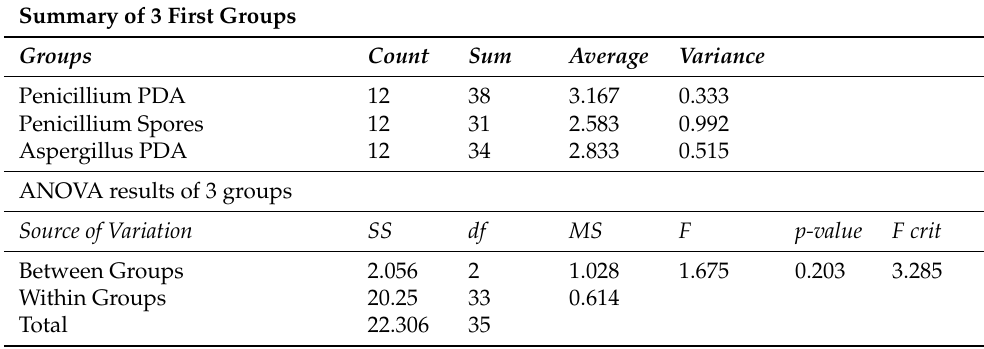
Table A2. ANOVA Single Factor Results comparing Penicillium and Aspergillus with PDA, and Penicillium in Tween.